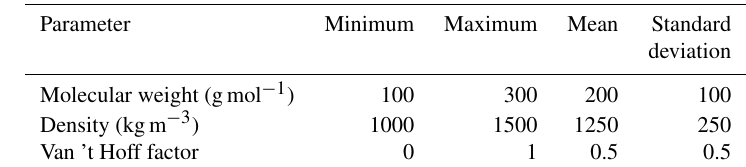
Table 5. The range of effective material parameters used for the compounds in each volatility bin. Minimum and maximum values are stated as well as the mean and standard deviation of the normal distribution from which values are sampled. Parameter